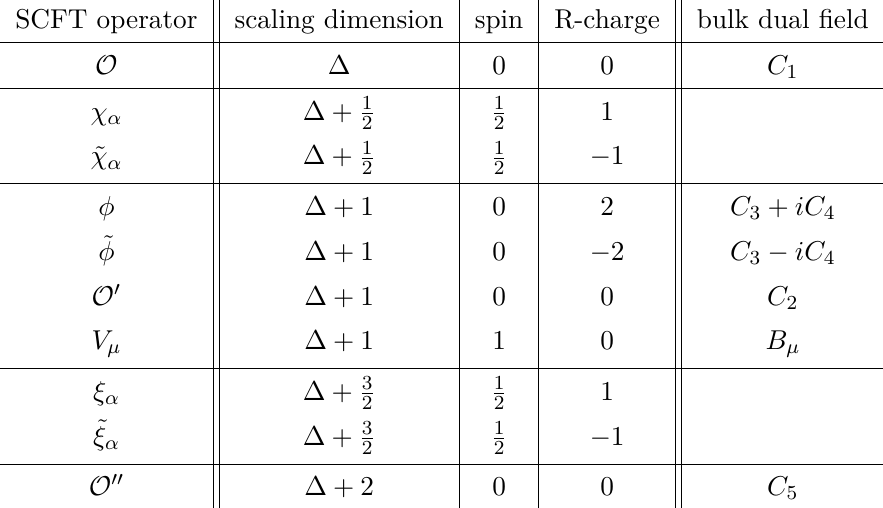
Table 5 . Operator content of a generic long scalar multiplet. Such a multiplet is dual to a massive vector